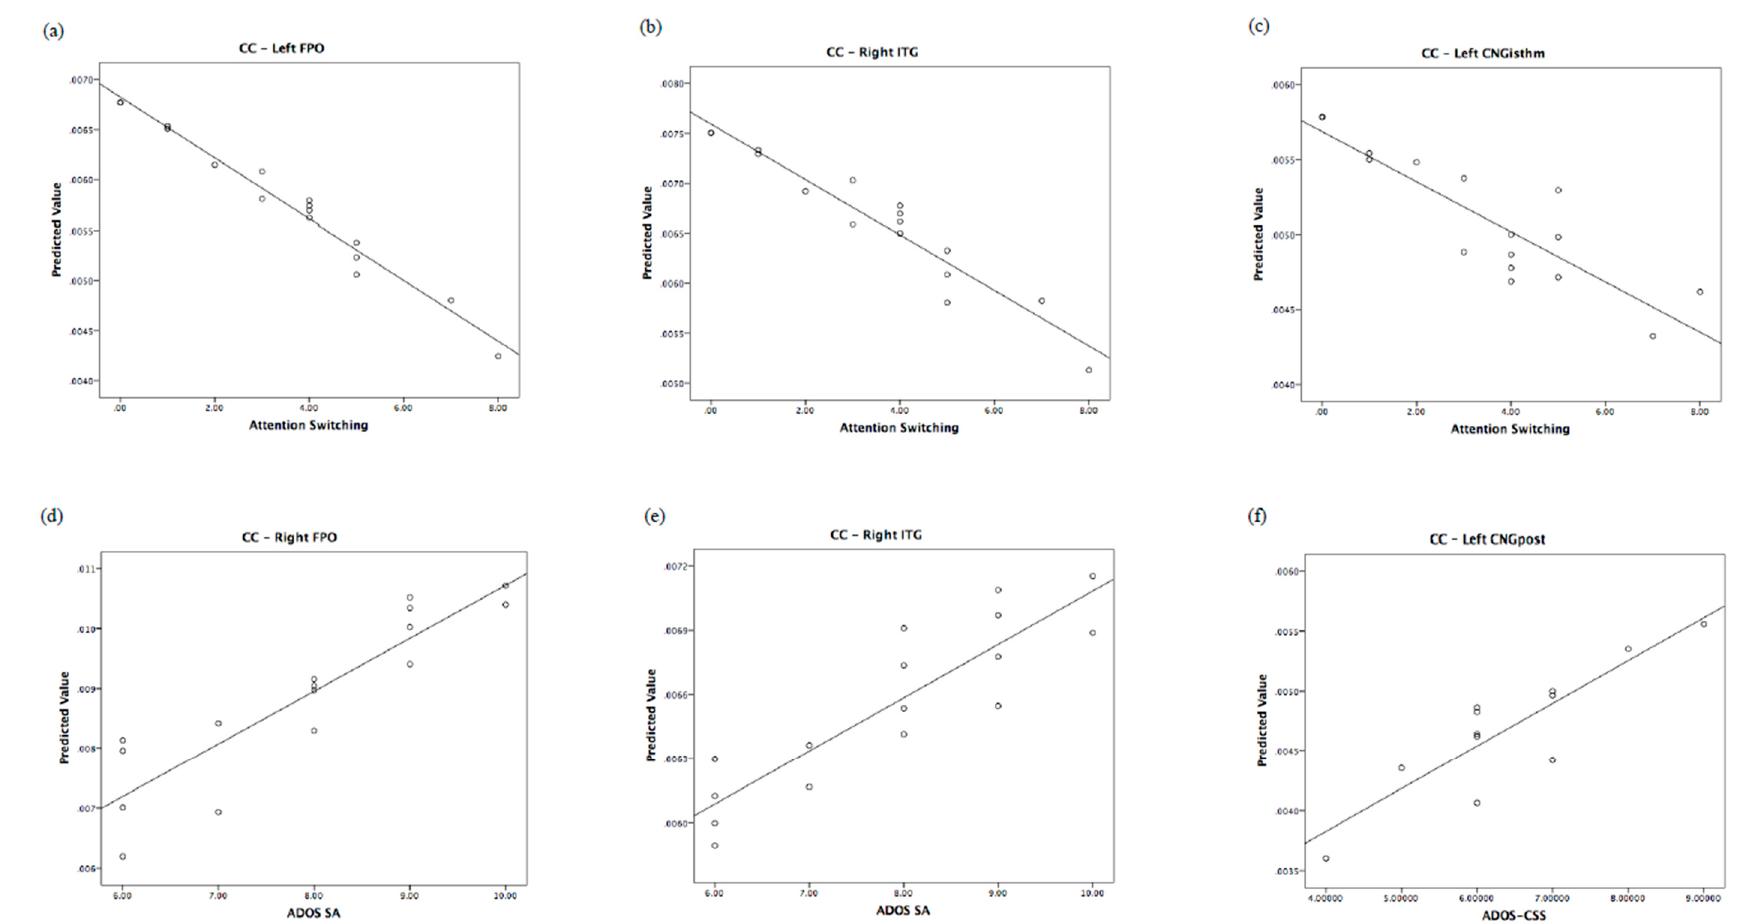
Figure 4. Regional clustering coefficient correlates of autistic traits in fathers and of autism severity in children. Top: predicted values vs. AQ domains in fathers. Bottom: predicted values vs. ADOS in children. CC: clustering coefficient.